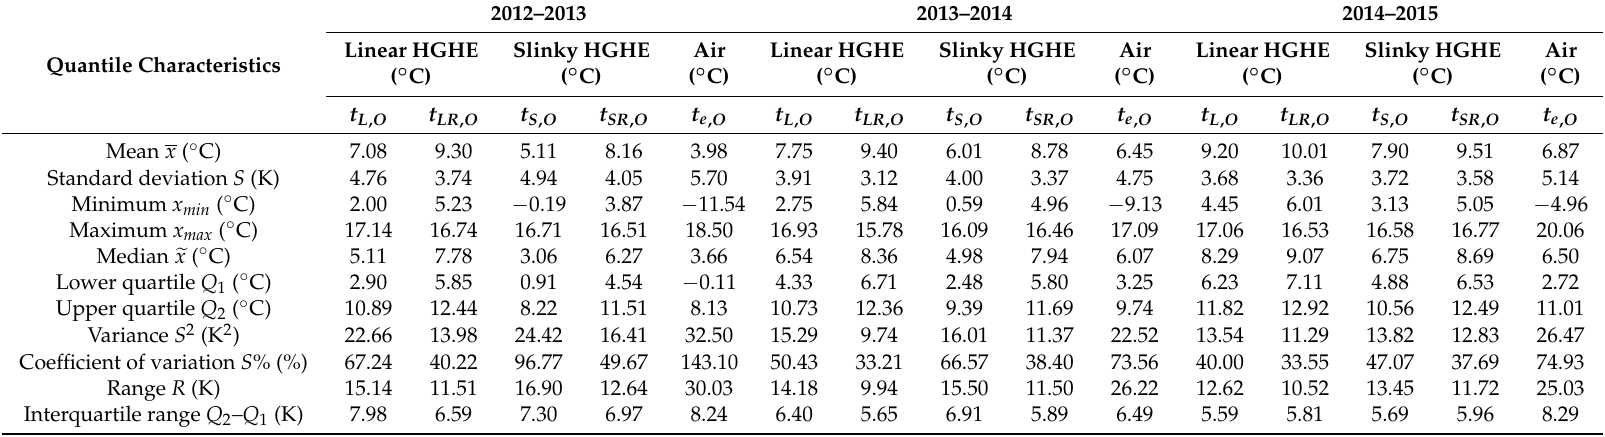
Table 1. Quantile characteristics of sets of average daily temperatures of ground masses in the proximities of HGHEs and ambient temperatures during heating periods.